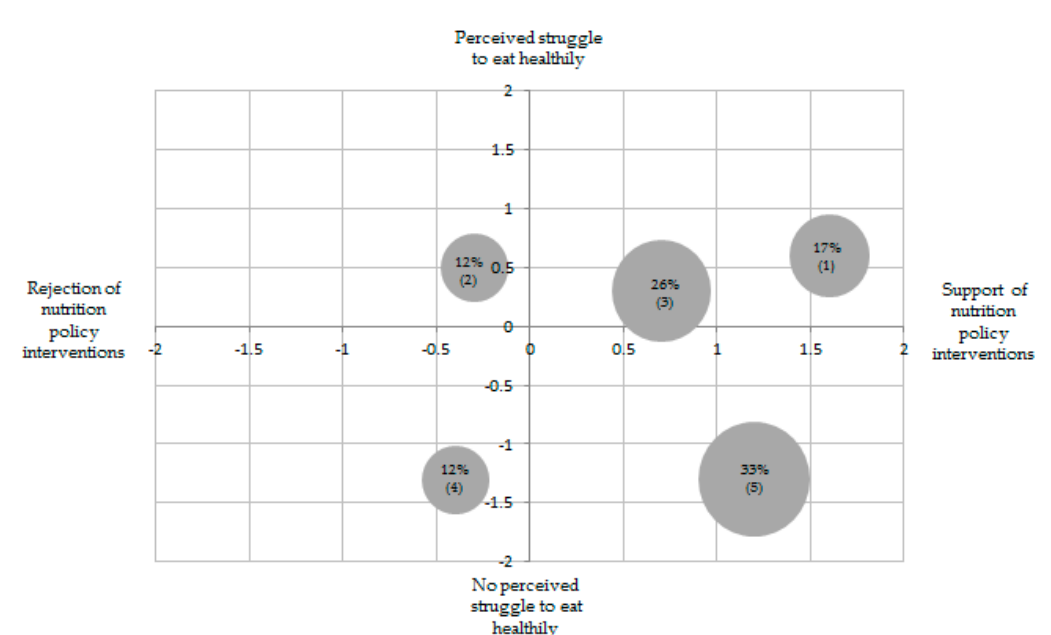
Figure 1. Cluster matrix (mean values). Notes: Numbers are the index values for each cluster, the mean values are added up of each variable and divided by the number of interventions (see Table 4); scale from: − 2 = “I do not agree at all” to + 2 = “I totally agree”; from left to right: 12% = health-conscious rejecters (4), 12% = health-unconscious rejecter (2), 26% = differentiating supporters (3), 33% = health-conscious advocates (5); 17% = help-seeking advocates (1).